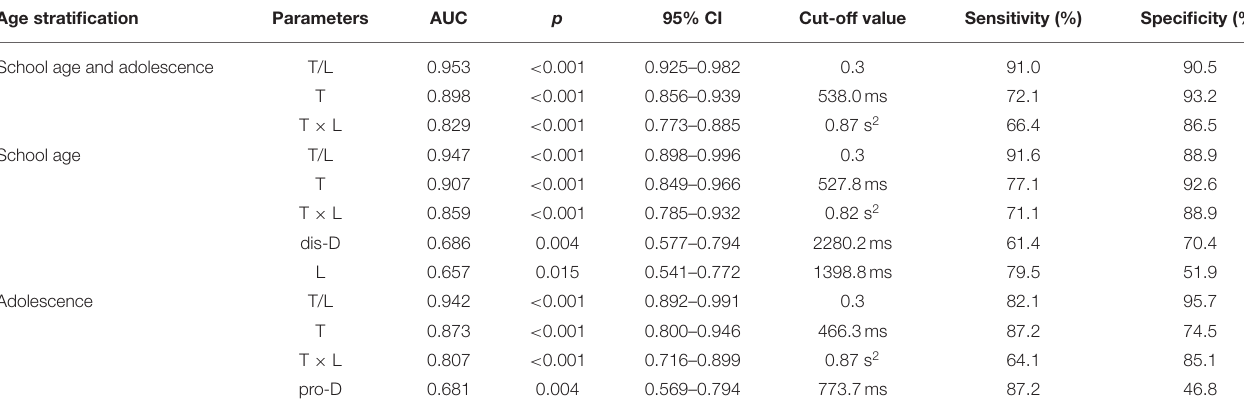
TABLE 4 | Differential diagnostic performance of Poincaré plot in distinguishing VVS from POTS in derivation study.